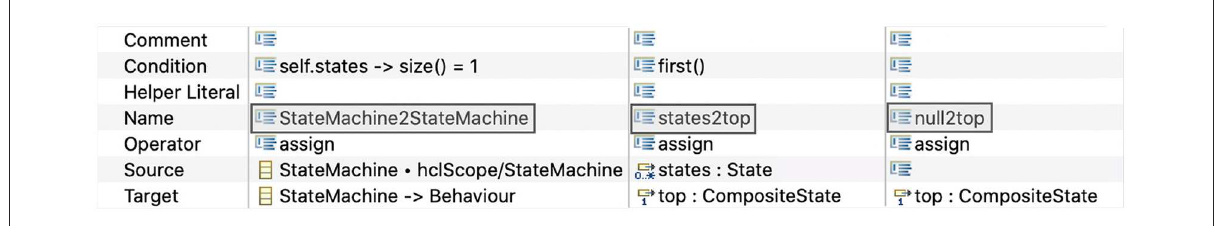
FIGURE9 Properties view for the mapping rules defined in Figure 6.